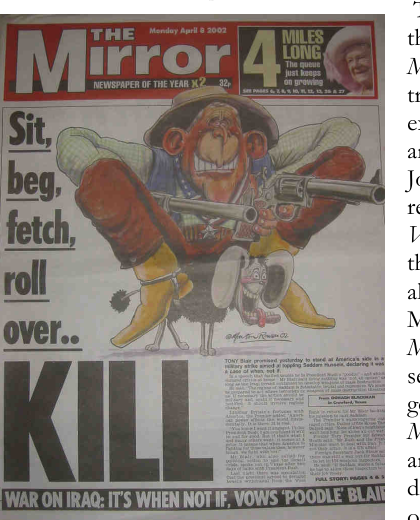
Figure 2. ‘Mirror attacks “poodle”